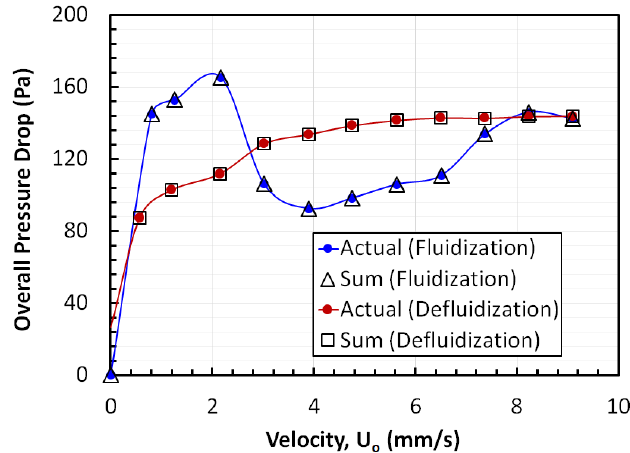
Figure 4. A comparison of the sum of the local pressure drops with the actual overall pressure drop, as represented by Equation (1).